Question: Which visualization type does this figure use?
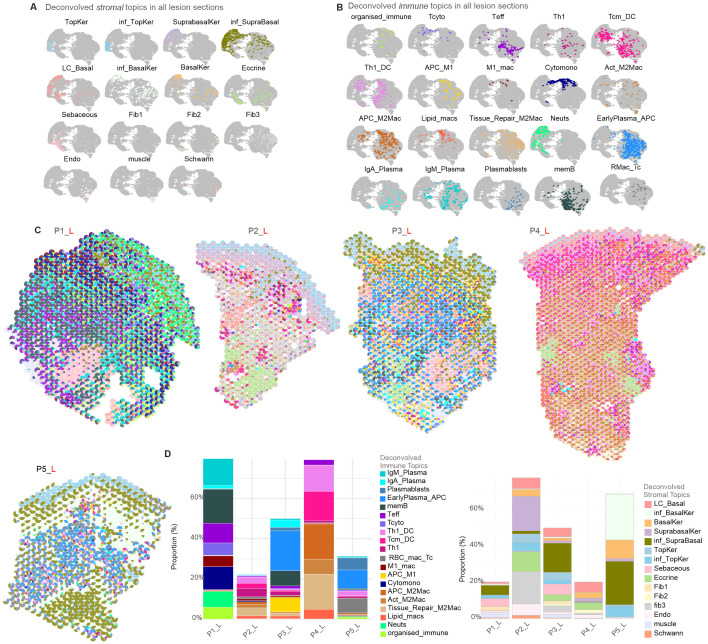
Answer: scatter